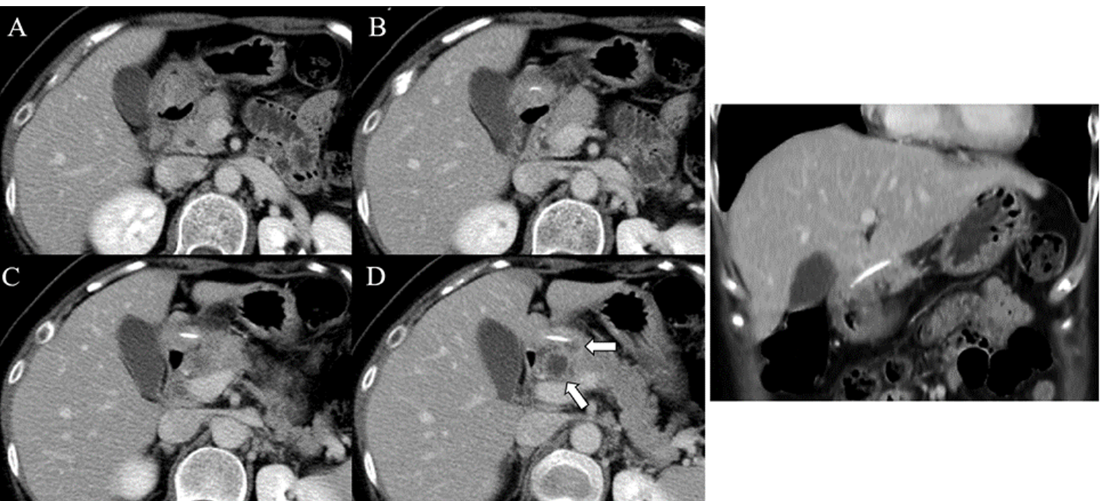
Figure 1. Contrast-enhanced CT imaging with serial sections in the axial ( A – D ) and coronal planes displaying a linear and hyperdense foreign body penetrating through the posterior wall of the gastric antrum into the pancreatic head. The white arrows indicate abscess formation in the pancreatic head and near the ingested foreign body.